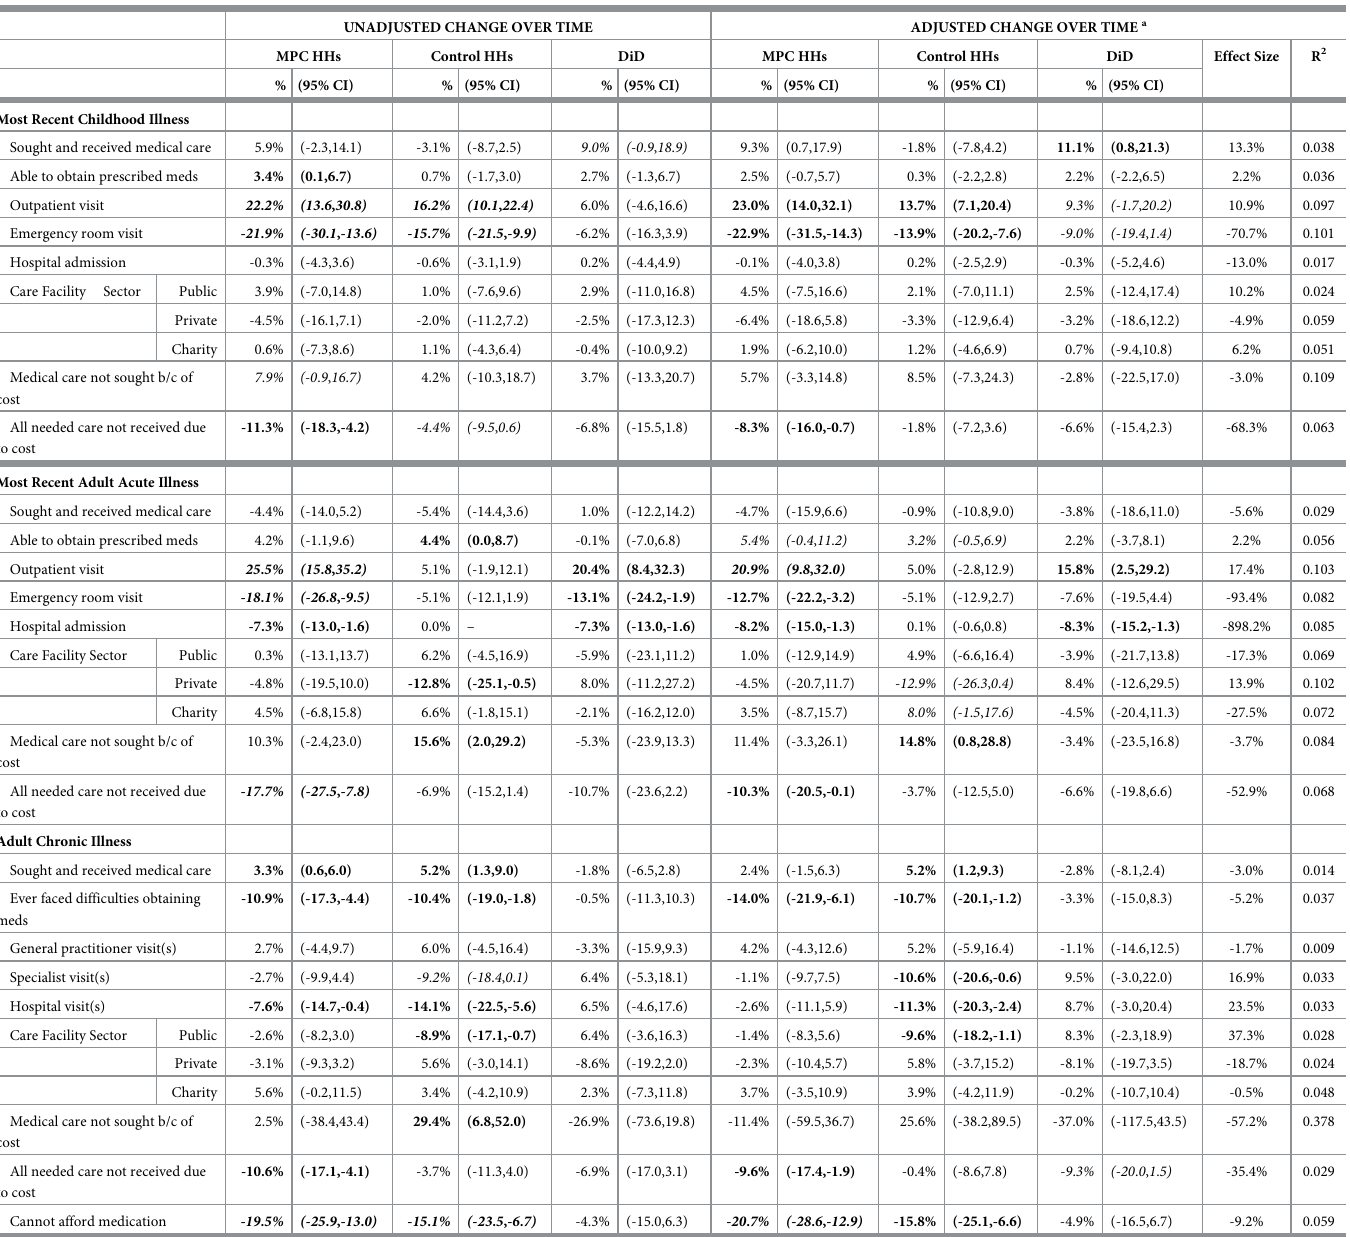
Table 4. Change in health care-seeking and medicines for household member illness. UNADJUSTEDCHANGEOVERTIME ADJUSTEDCHANGEOVERTIME a MPCHHs ControlHHs DiD MPCHHs ControlHHs DiD EffectSize R